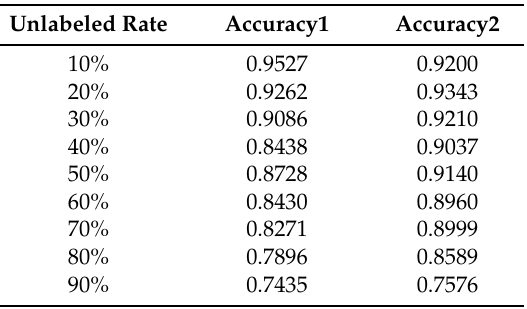
Table 9. Outcome of M-S4VMs at different unlabeled rates.